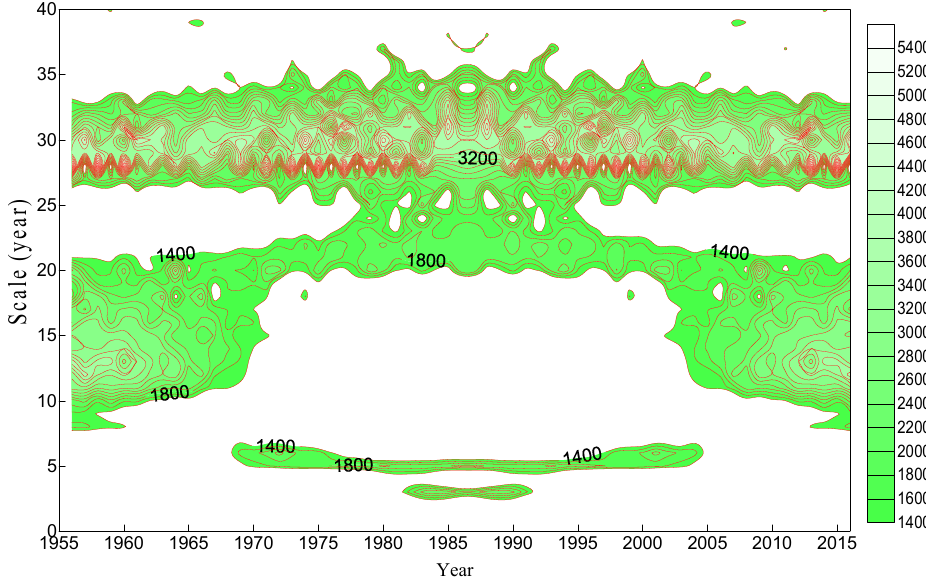
Figure 8. Modulus square of wavelet coefficient contour map of streamflow at Tangnaihai station.